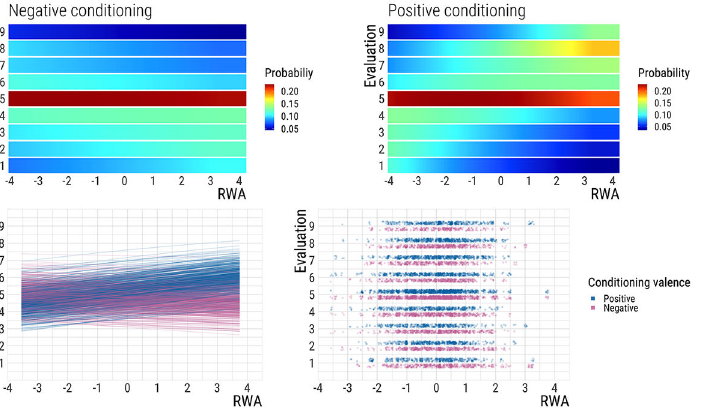
Note. Top: Evaluation of stimuli after counter-conditioning as a function of RWA and conditioning valence: negative (left) vs. positive (right). Based on the estimation given by the ordinal model. Correct graphical representation of the output of the model. Bottom left: Evaluation of stimuli after counter-conditioning as a function of RWA and conditioning valence. Based on the estimation given by the ordinal model but adapted as a linear representation. This representation is simply given in order to permit familiarity but does not rigorously represent the ordinal nature of the model. The lines correspond to randomly sampled credible regression lines. Bottom right: Distribution of the data points.